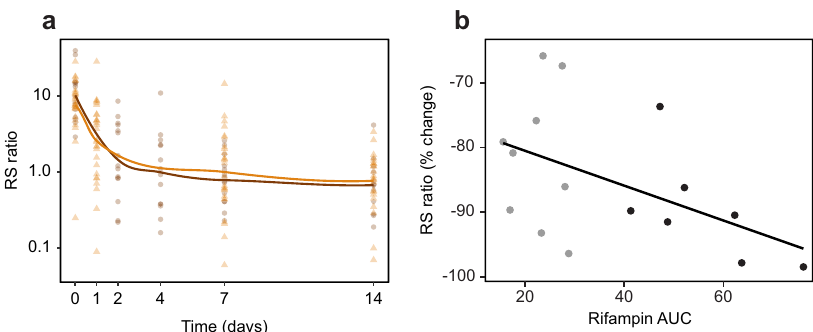
Fig. 6 Sputum RS ratio declines rapidly with standard treatment and a dose-response relationship is evident. a Longitudinal change in the RS ratio in serial sputa among Ugandan and Vietnamese adults treated with HRZE for drug-susceptible TB. Brown and orange dots indicate individual patients from Uganda and Vietnam, respectively. The solid line is a Lowess fi t. b Association between rifampin exposure (AUC) and change in sputum RS ratio between pre-treatment and day 14 among Beninese patients treated with HRZE with rifampin 10 mg kg − 1 (gray) or 15 mg kg −